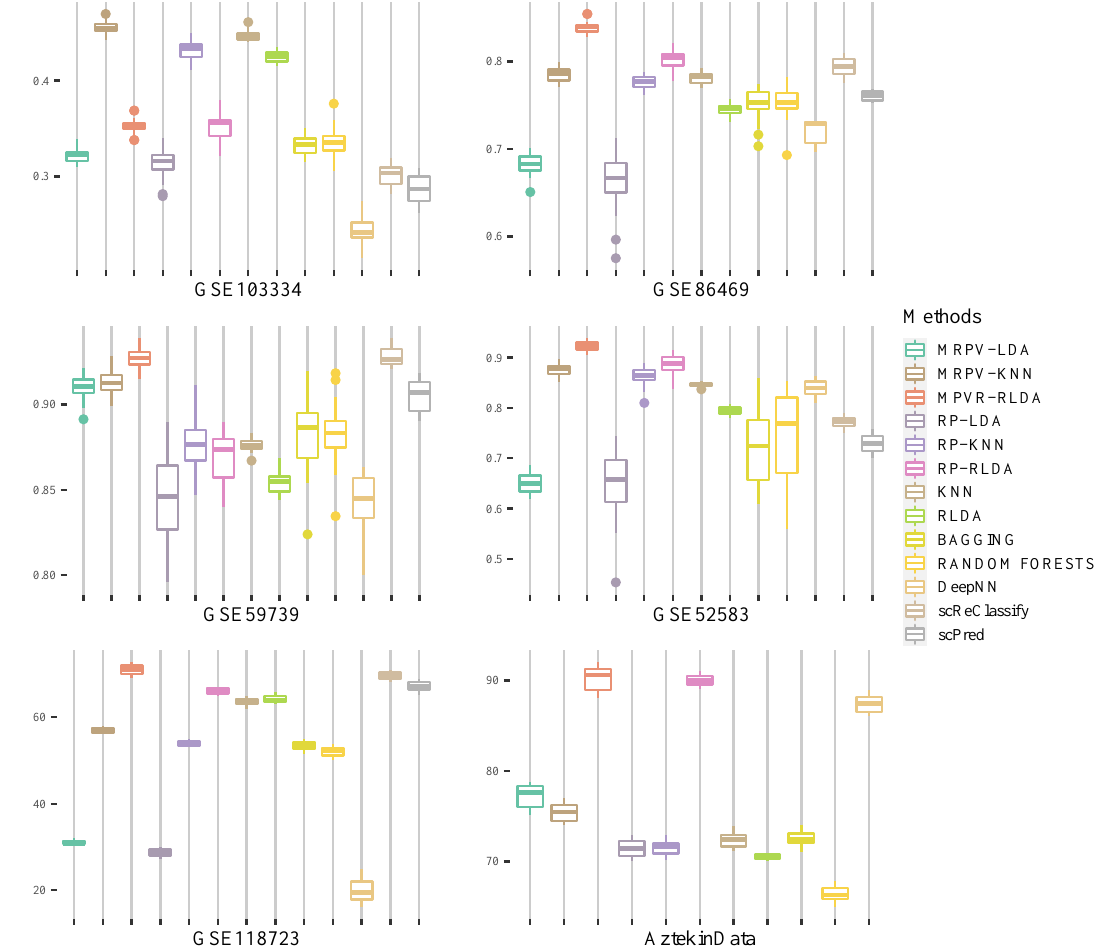
Figure 5. Classification performance of the proposed MRPV framework (MRPV-LDA, MRPV-KNN, MRPV-RLDA) compared to other ten classification methods for the datasets GSE103334, GSE86469, GSE59739, GSE52583, GSE118723, and AztekinData. Evaluation testing is made by examining F1-score. Boxplots imprint the values via 100 independent executions for each